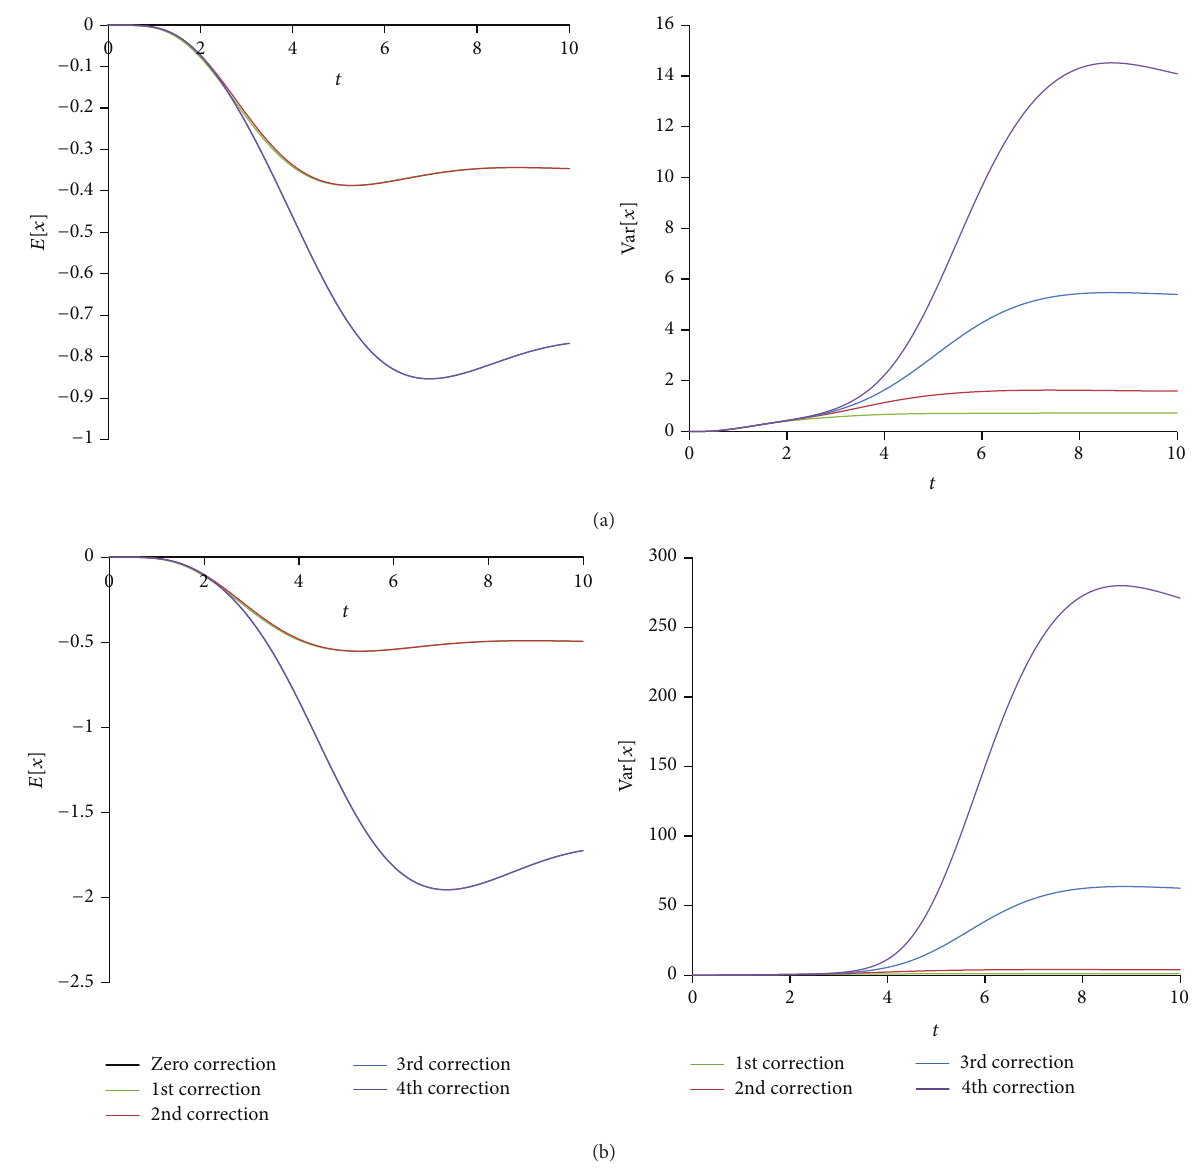
Figure 8: The second-order response mean and variance for (a) 𝜀 = 0.7 and (b) 𝜀 = 1.0